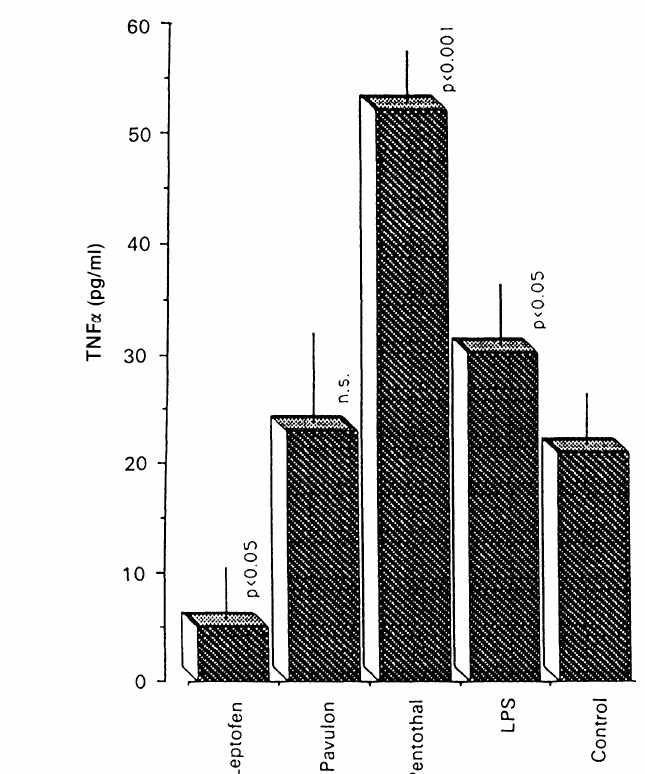
FIG. 1. TNF levels in supernatants of PBMCs driven by either anaesthetics (Leptofen, Pavulon, Pentothal) or LPS as well as in supernatants of unstimulated PBMCs. Anaesthetics were used at the optimal concentration of 10/g/ml. The results are shown as the mean levels of TNF of triplicate experiments ___standard deviation. See Materials and Methods for details.